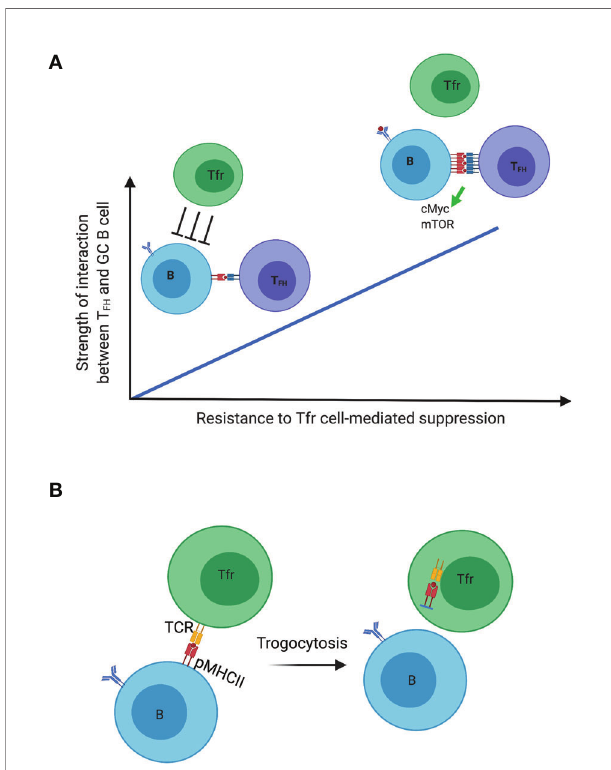
FIGURE 1 | Dynamic regulation of germinal center B cells mediated by Tfr cells. (A) Model 1; (B) Model 2. Created with